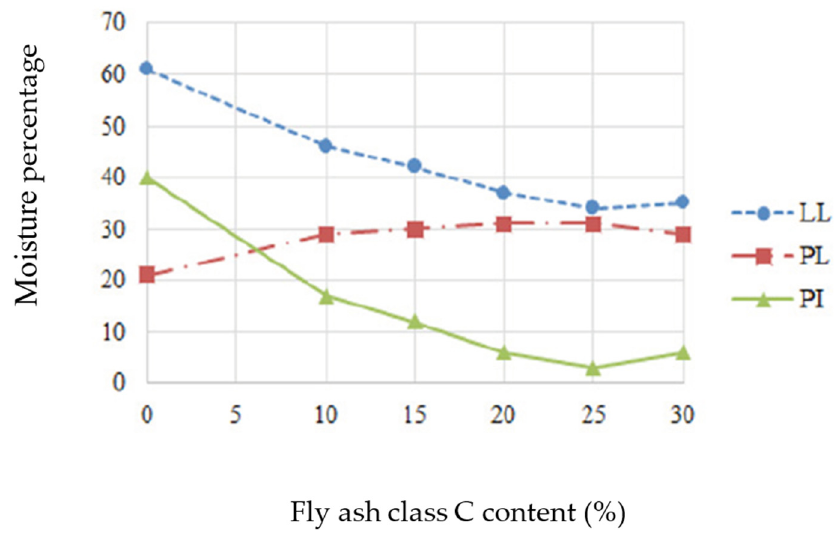
Figure 2. Fly ash class C impact on clay Atterberg limits.